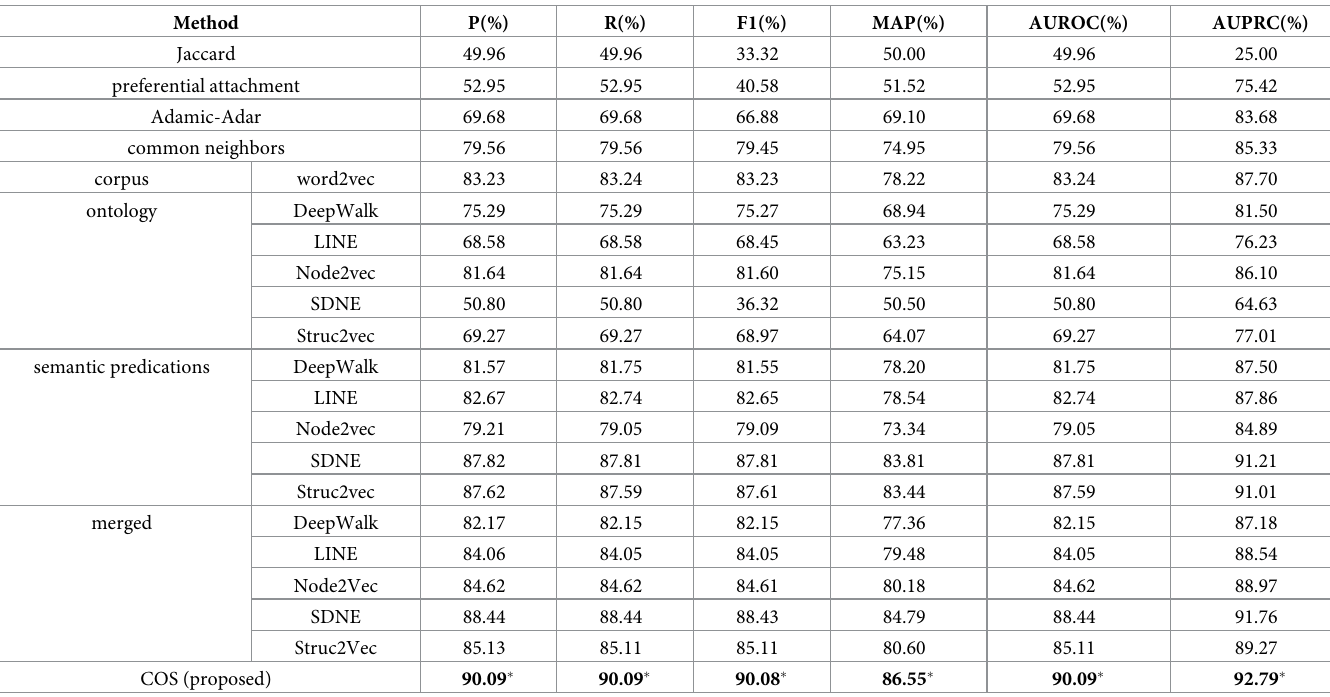
Table 6. Edge prediction results for